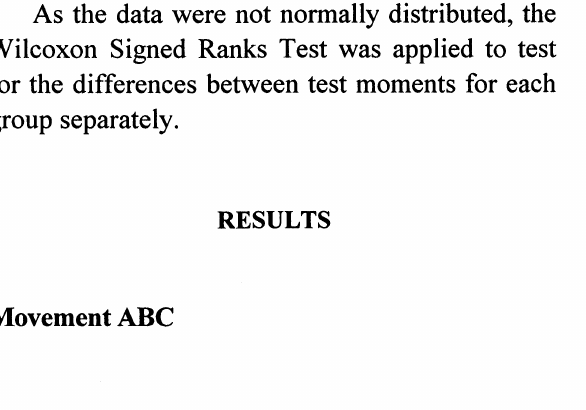
Fig. 1" Median total scores on the Movement-ABC for the treatment group and the no-treatment control group at each test moment.